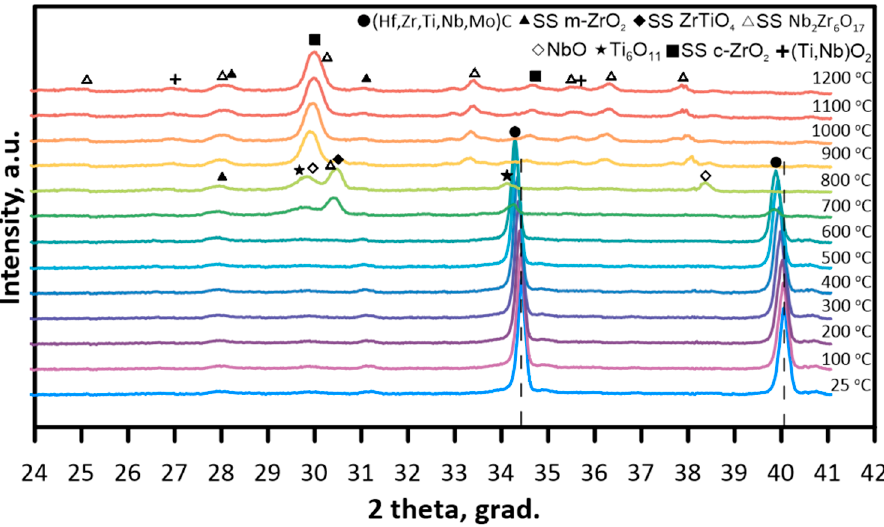
Figure 3. Diffractograms of (Hf,Zr,Ti,Nb,Mo)C sintered ceramics during the heating from 25 to 1200 °C.